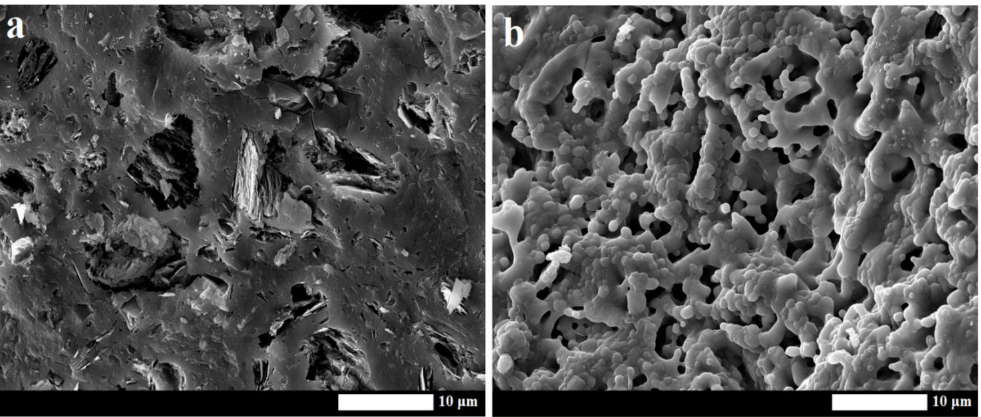
Figure 11. Micrographs of geopolymer binder at room temperature ( a ) and after exposure to 1200 ◦ C ( b